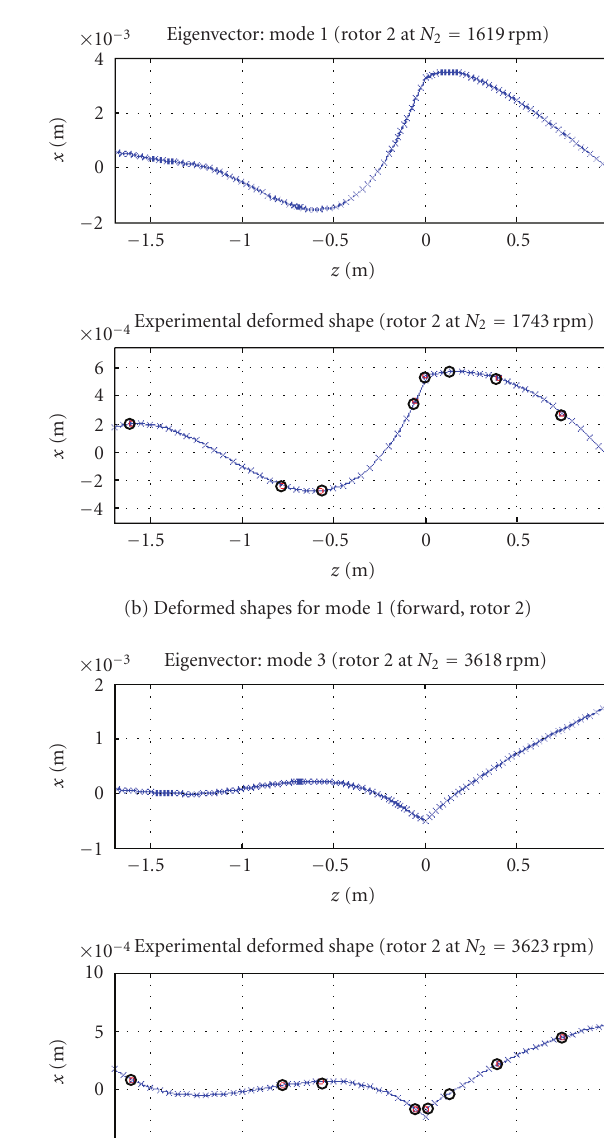
Experimental deformed shape (rotor 1 at N 1 = 1875rpm)